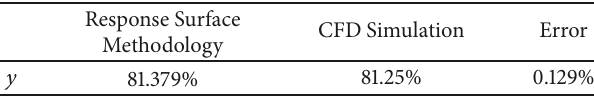
Table 9: Model prediction values and numerical simulation